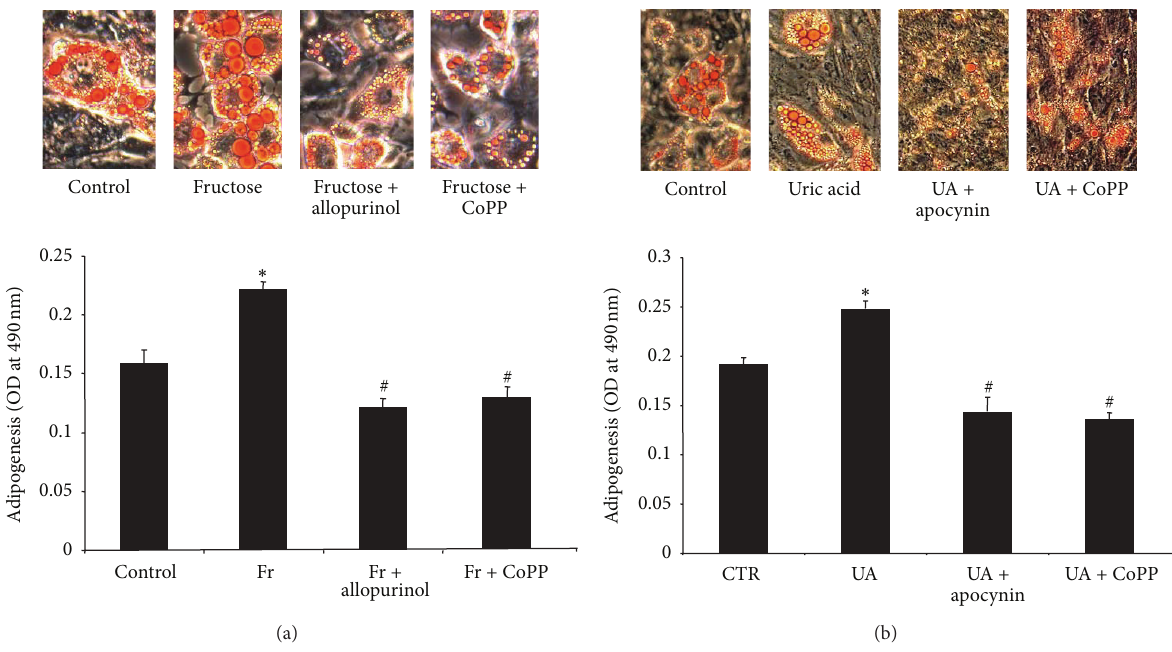
Figure 7: (a) Adipogenesis as shown by Oil Red O staining in MSCs treated with 500 𝜇 M fructose with or without CoPP and with or without allopurinol, a known inhibitor of XO. A representative section for each group is shown; ∗ 𝑝 < 0.05 versus CTR; # 𝑝 < 0.05 versus Fr. (b) Adipogenesis as shown by Oil Red O staining in MSCs treated with 5mg/dL uric acid with or without CoPP and with or without apocynin, a known inhibitor of NADPH oxidase, magnifications: 40x ( 𝑛 = 5 ). A representative section for each group is shown. Values represent means ± SEM of five independent treatments. ∗ 𝑝 < 0.05 versus CTR; # 𝑝 < 0.05 versus UA.